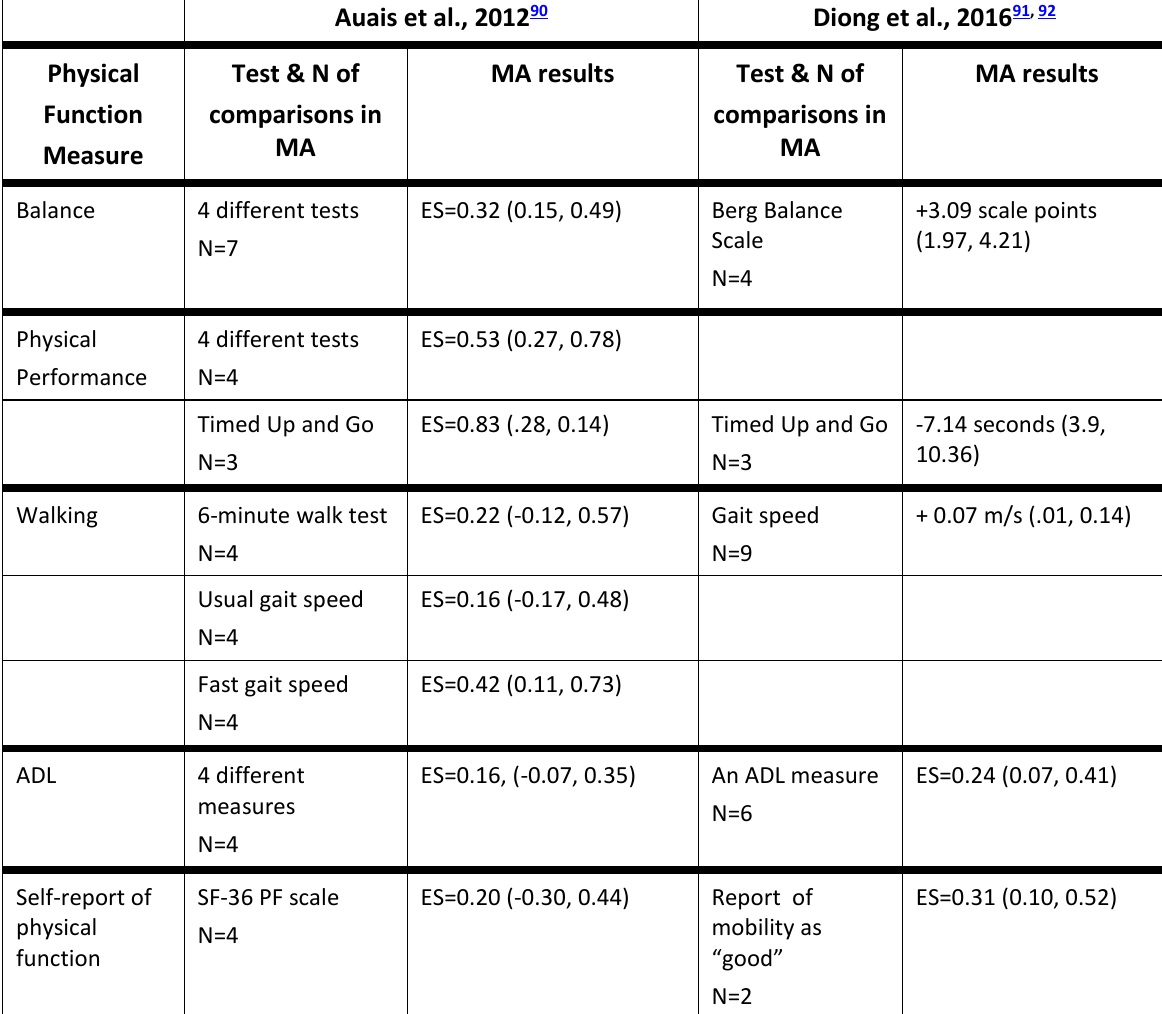
Table F9-2. Effect Sizes for the Relationship Between Physical Activity and Physical Function in Older Adults After Hip Fracture Auais et al., 2012